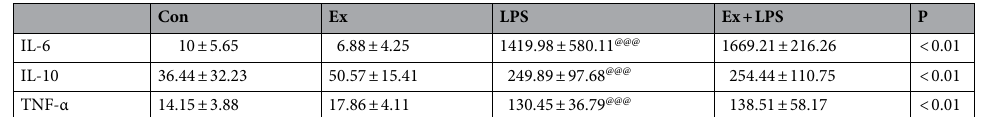
Table 3. Cytokine levels in serum (pg/mL). The levels of IL-6, IL-10, and TNF-α in serum were detected. @ P < 0.05, Con versus LPS groups.